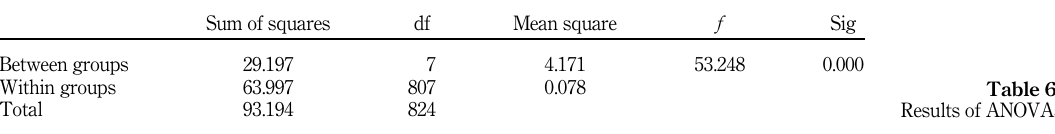
Table 5. Results of ANOVAs